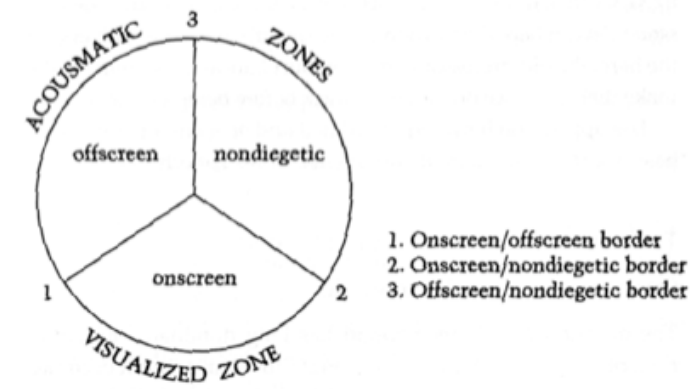
Figure 3: Michel Chion’s Space on